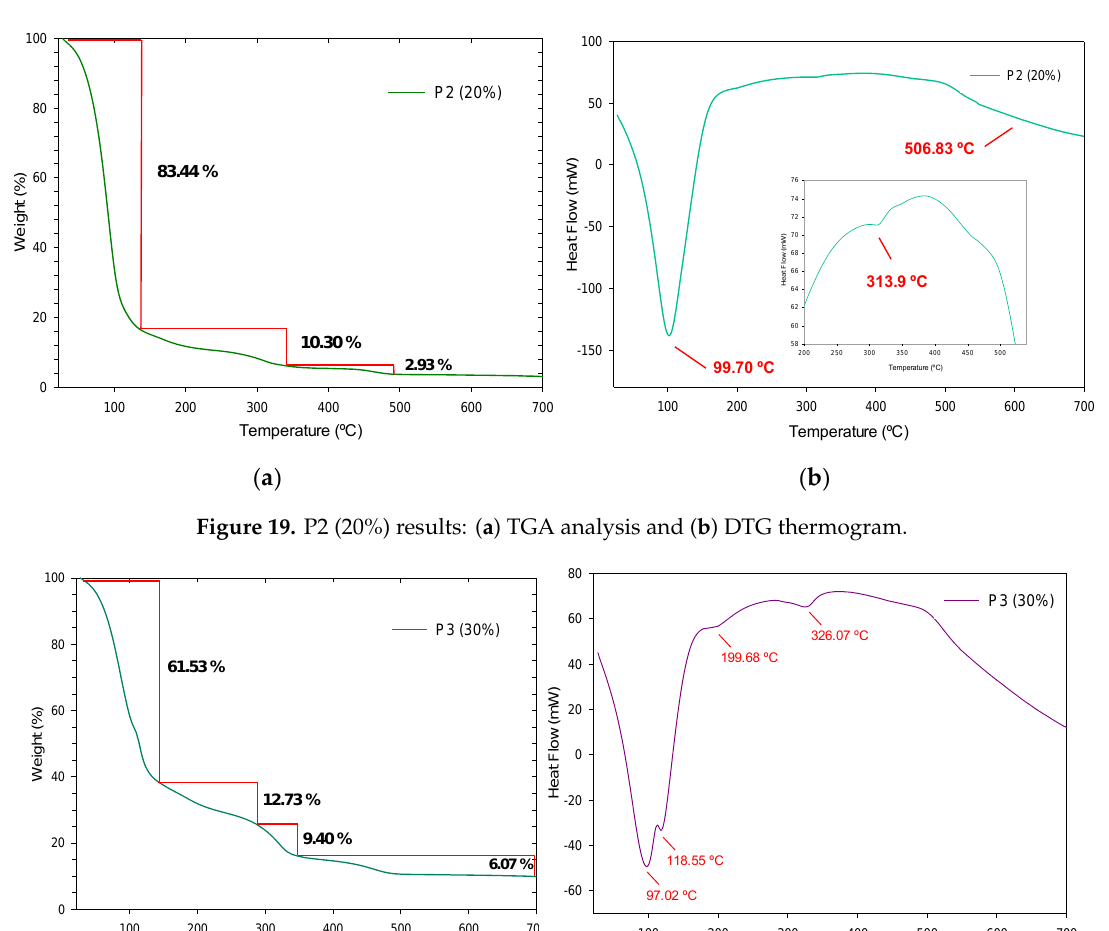
( b ) Figure 21. P4 (40%) results: ( a ) TGA analysis and ( b ) DTG thermogram.